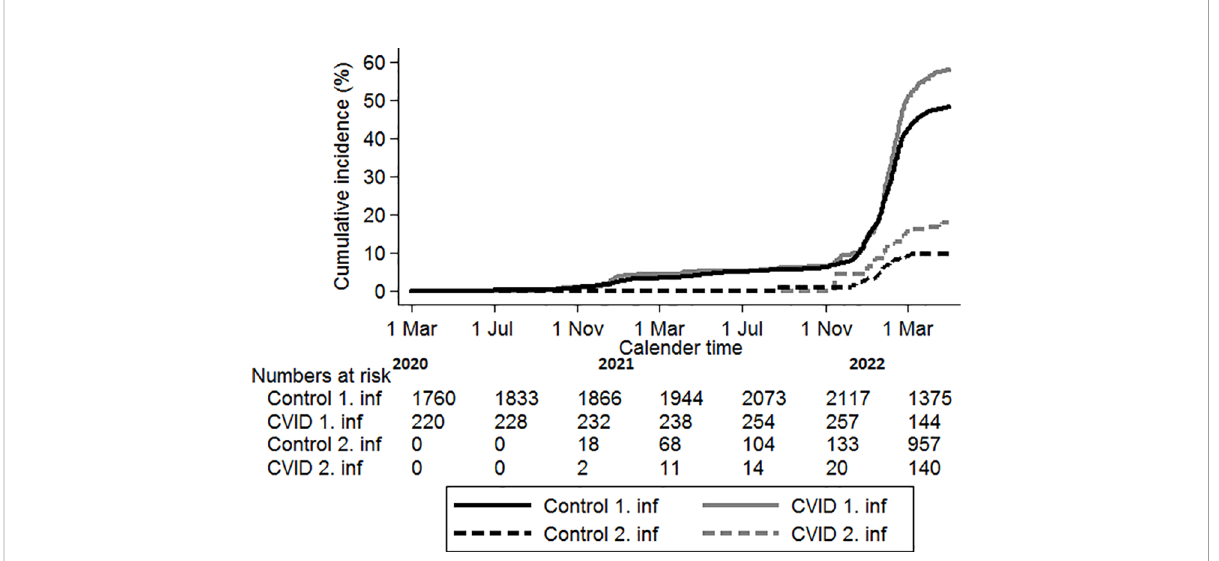
FIGURE 2 Time to fi rst and second positive SARS-CoV-2 test. Solid lines: fi rst positve test, dotted line: second positive SARS-CoV-2 test. Black lines: population controls, gray lines: CVID